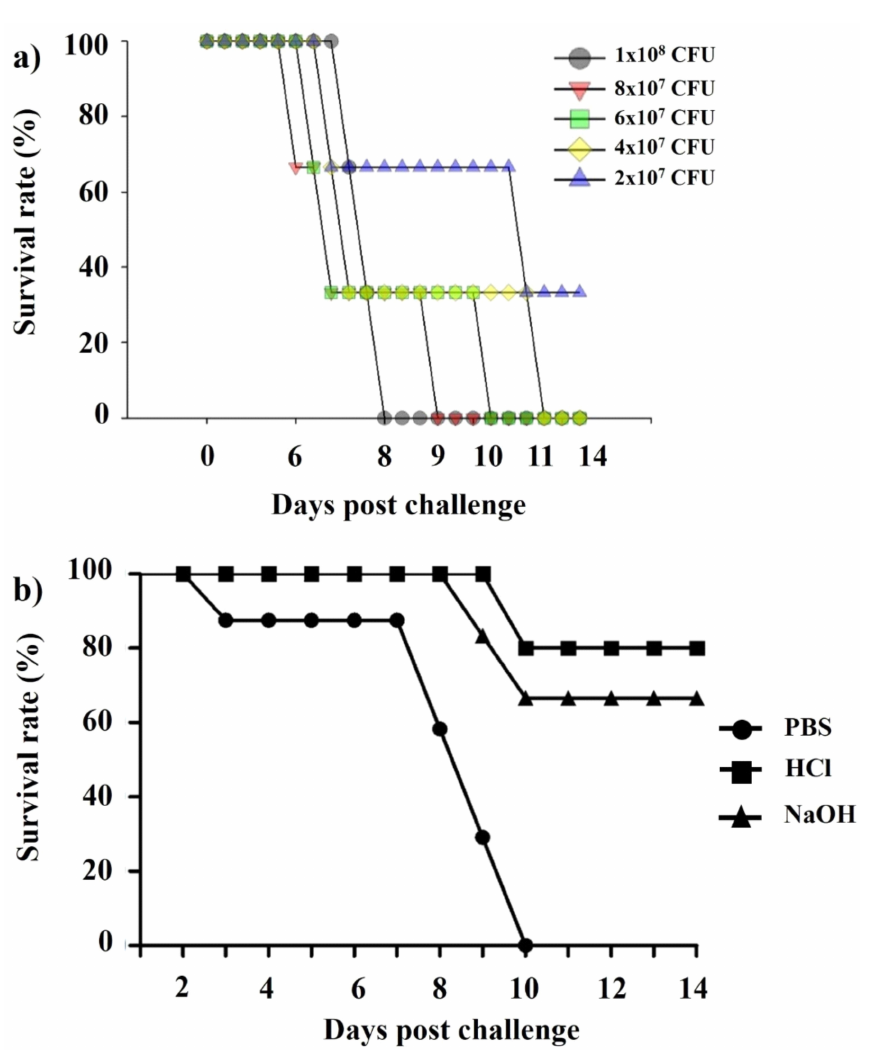
Figure 9. ( a ) Kaplan–Meier survival analysis for the BALB/c mice ( n = 5) inoculated with dif- ferent concentrations (1 × 10 8 , 8 × 10 7 , 6 × 10 7 , 4 × 10 7 , and 2 × 10 7 CFU /100 µ L) of Lm and ( b ) Kaplan–Meier survival analysis for BALB/c mice ( n = 8) immunized with PBS, HCl-induced LMGs, and NaOH-induced LMGs and challenged subcutaneously with Lm (2 × 10 7 CFU /100 µ